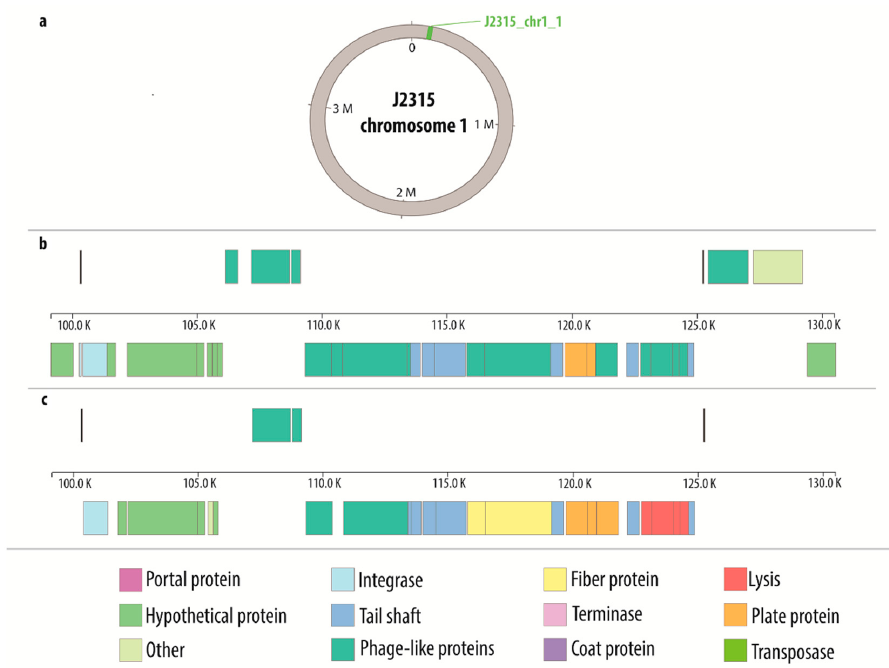
Figure 1. Comparative map of J2315_chr1_1 phage region: ( a ) general location of the phage on the host chromosome; ( b ) genes characterization based on PHASTER annotation; ( c ) genes characterization based on manual annotation.